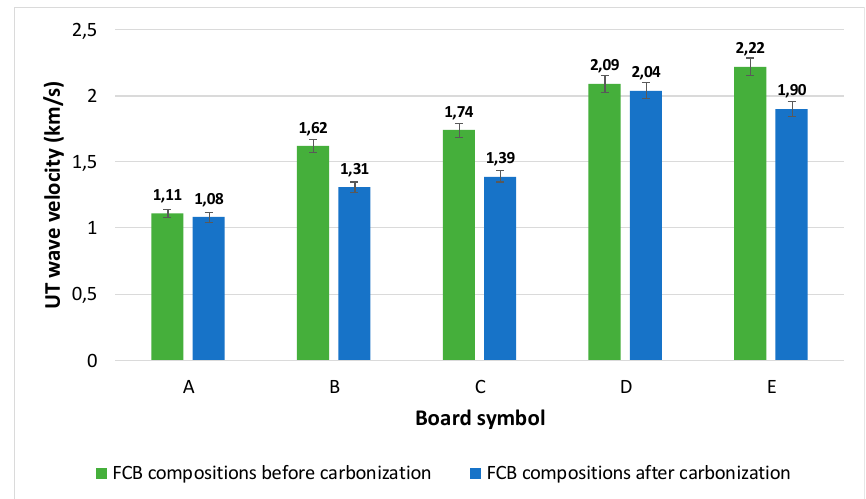
Figure 9. Results of the UT longitudinal wave velocity c L tests, measured in all FCB compositions, before and after carbonization. The black marks depict standard deviations (2%–3%), determined in populations of the measurements.